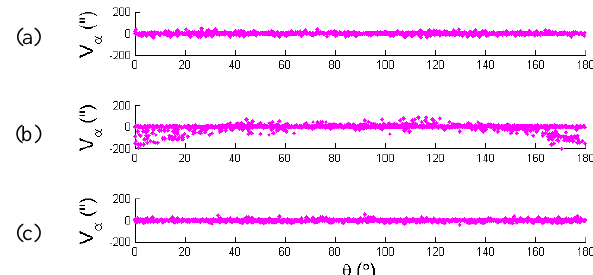
Figure 5: (a) Vertical angle residuals versus range horizontal angle in plane-based self-calibration for panoramic scanners without systematic errors. (b) Unmodelled 3’ vertical circle index error. (c) After plane-based self-calibration.